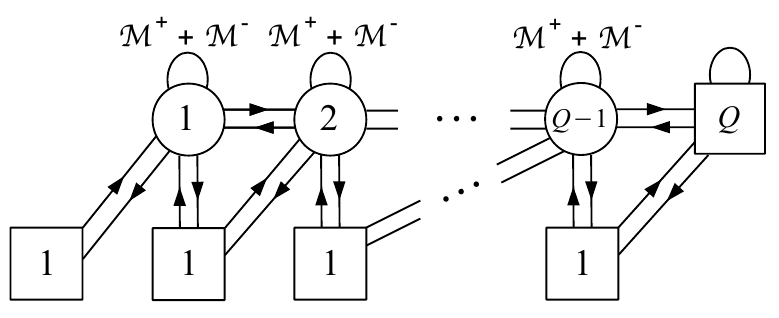
Figure 21: Quiver diagram of the three-dimensional F M [ U ( Q )] theory. Both square and circular nodes denote U ( n ) symmetries. Double-lines connecting two nodes rep- resent pairs of bifundamental chirals in conjugate representations with respect to the corresponding symmetries. Lines that start and end on the same node correspond to chirals in the adjoint